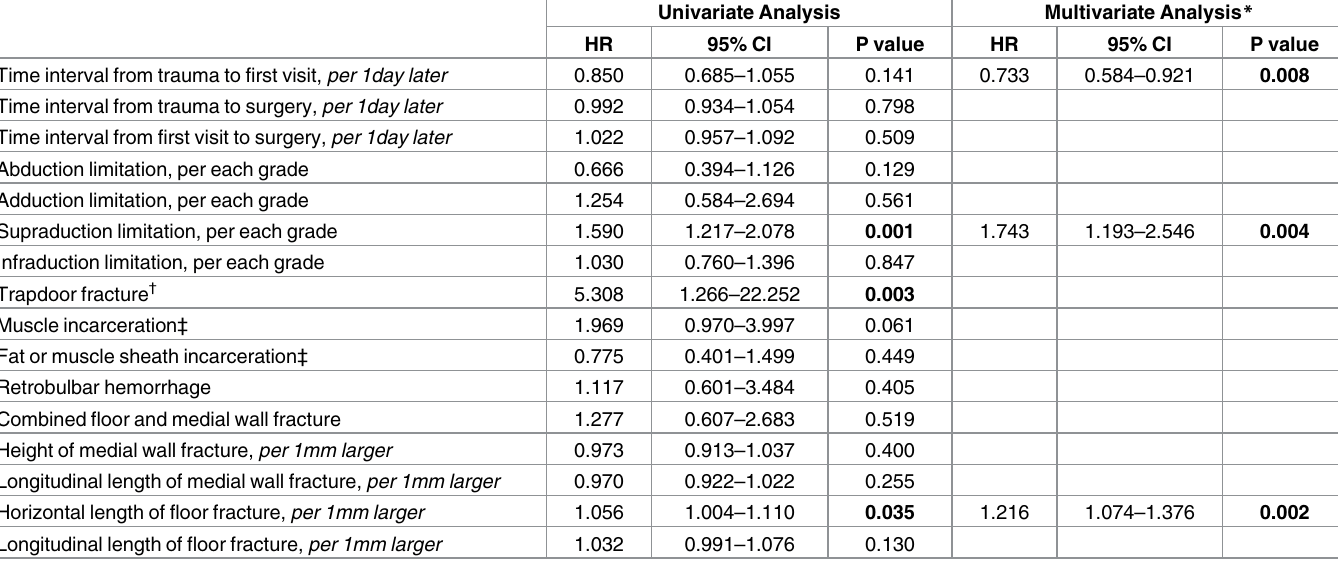
Table 3. Factors associated with resolution of patient-reported